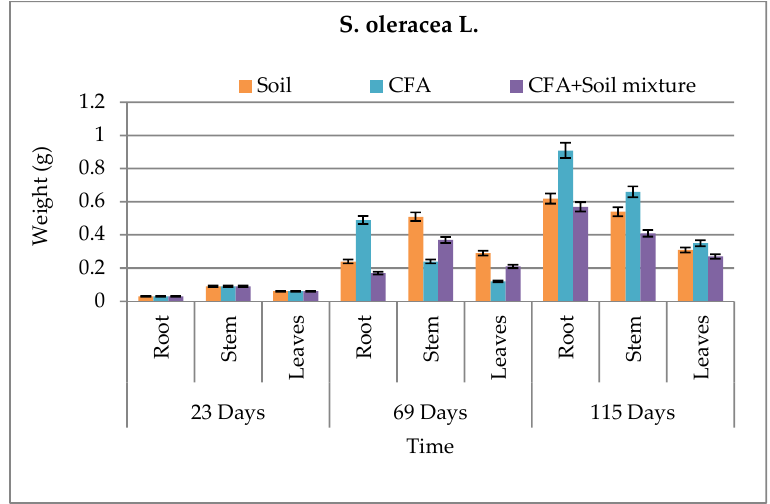
Figure 5. Above- and below-ground biomass for S. oleracea L. in all growth media. CFA: Coal-fly-ash.